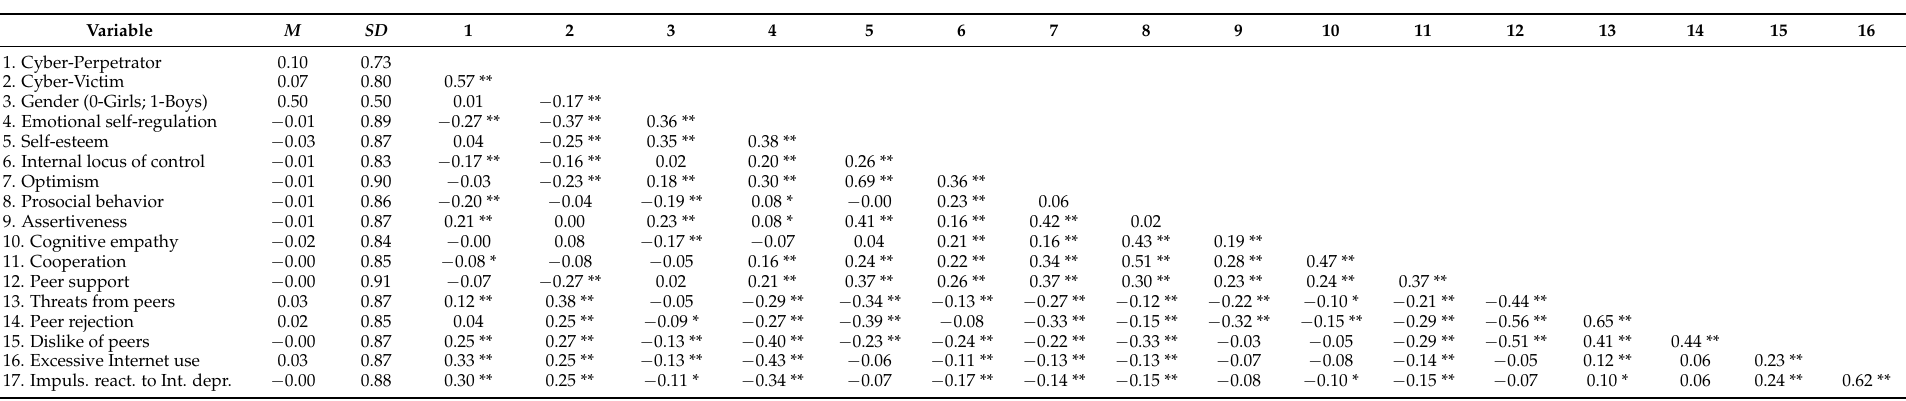
Table 4. Means, standard deviations, and